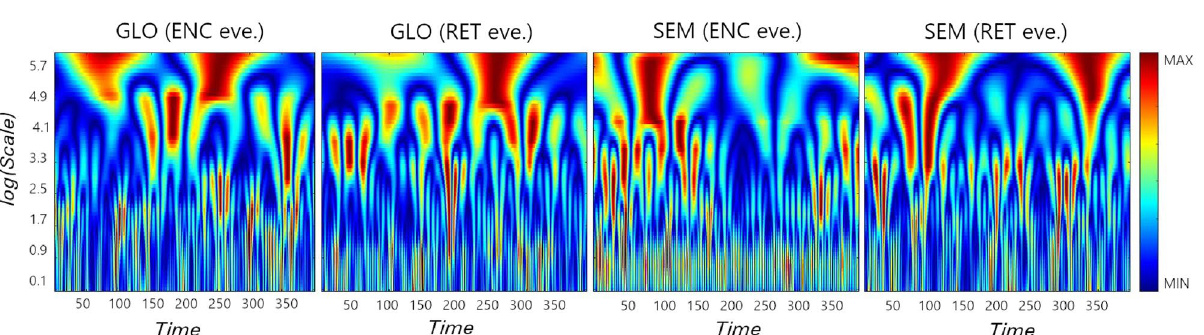
Figure 5. Scalogram of the signals from ROI no. 54 (Visual II RSN) in evening (eve.) for two tasks, GLO and SEM, in memory encoding and retrieval phases. The W ψ amplitude is coded by 256 colours. Experimental phases ( ENC encoding, RET retrieval), visual-verbal tasks ( SEM semantic), visual-nonverbal tasks ( GLO global information